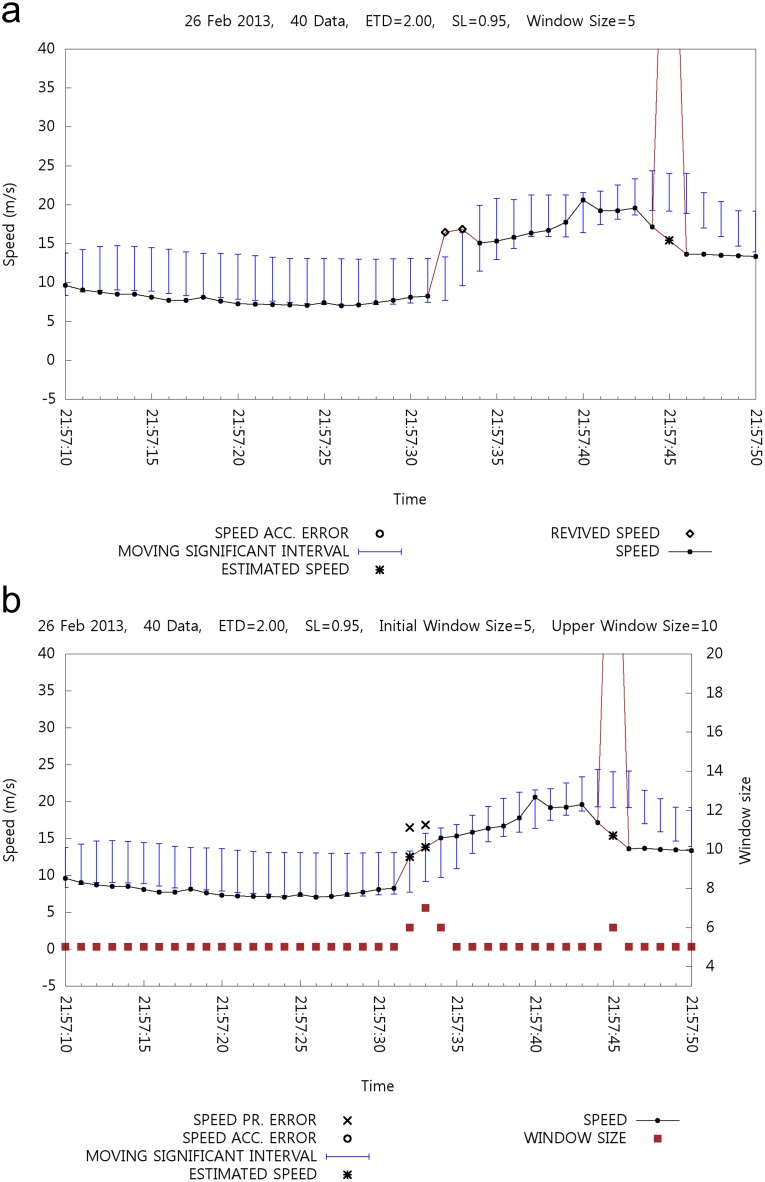
Case2: Effect of Window Size Adjustment.